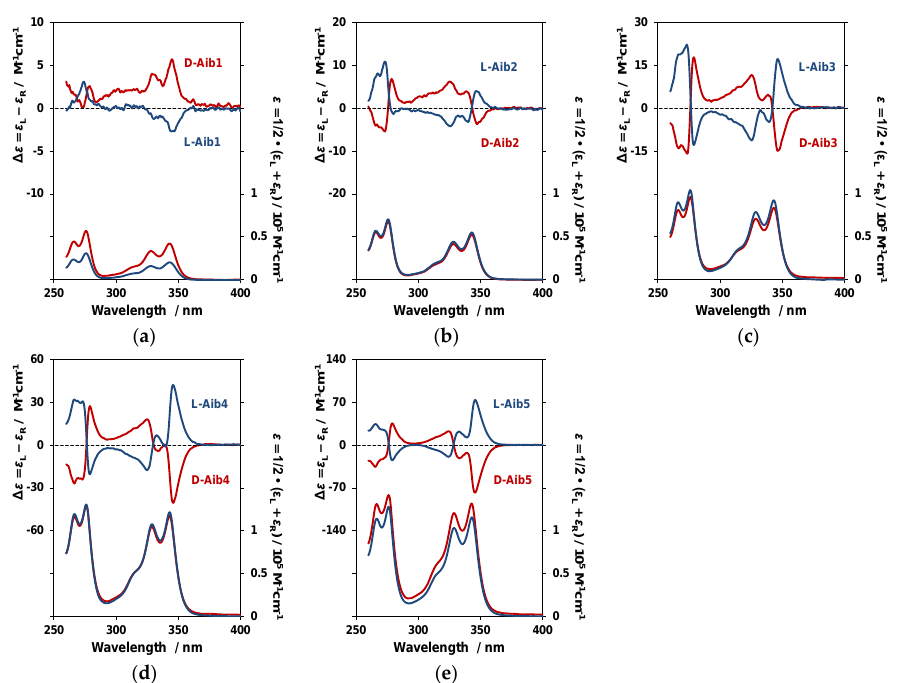
Figure 3. CD (upper panel) and UV–Vis (lower panel) spectra of ( a ) D -Aib1 / L -Aib1 ; ( b ) D -Aib2 / L -Aib2 ; ( c ) D -Aib3 / L -Aib3 ; ( d ) D -Aib4 / L -Aib4 ; and ( e ) D -Aib5 / L -Aib5 in CHCl 3 (1.0 × 10 −4 M). D -isomer and L -isomer spectra are shown by red and blue lines, respectively. Path length = 1 mm.